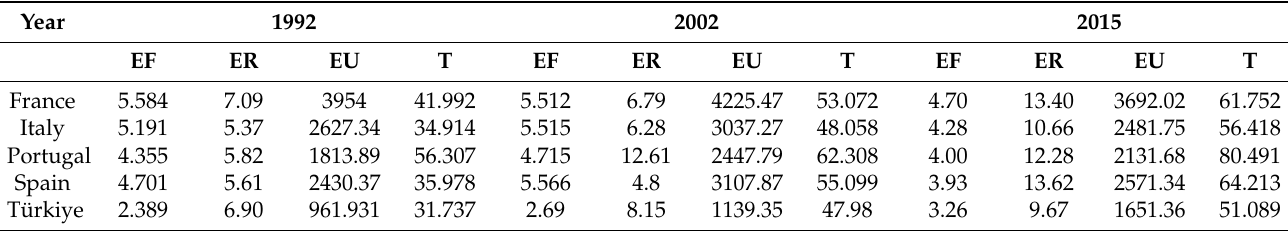
Table 2. Country-level